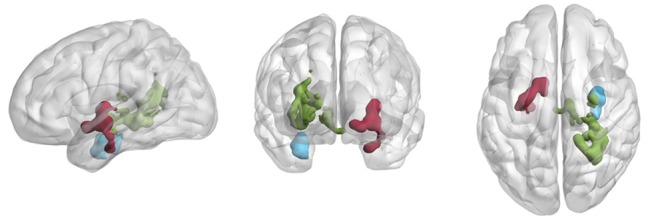
Relationship between aerobic capacity and fluctuations of BOLD signal (BOLDSTD) at baseline. For three regions in medial temporal areas, we observed a negative relationship between aerobic capacity and BOLDSTD. Green: a cluster (973 voxels) extending parts of right posterior hippocampus and thalamus. Red: cluster (298 voxels) extending parts of L. Putamen, (l) thalamus and (2) amygdala. Blue: cluster (232 voxels) extending part of right anterior hippocampus and amygdala. Results are visualized using brain net viewer (Xia et al., 2013).